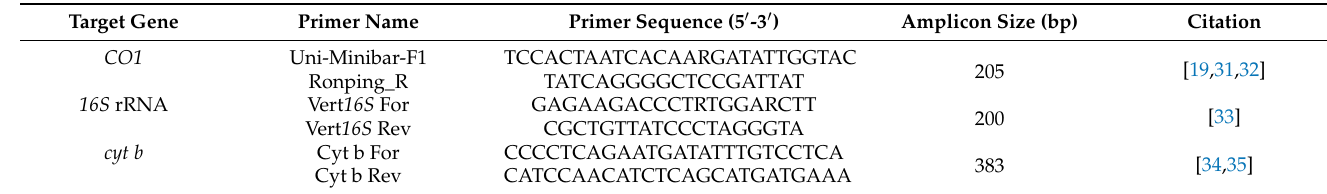
Table 1. Oligonucleotide primers used for vertebrate identification. Target